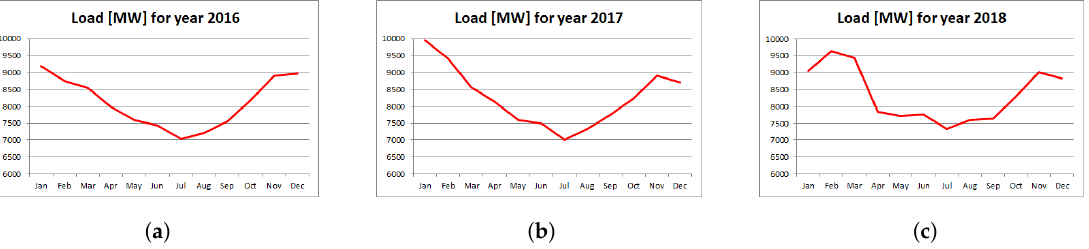
Figure 2. Power Load of the Czech Republic for Years 2016, 2017, and 2018 from ˇCEPS, a.s. ( a ) Power load for the year 2016; ( b ) Power load for the year 2017; ( c ) Power load for the year